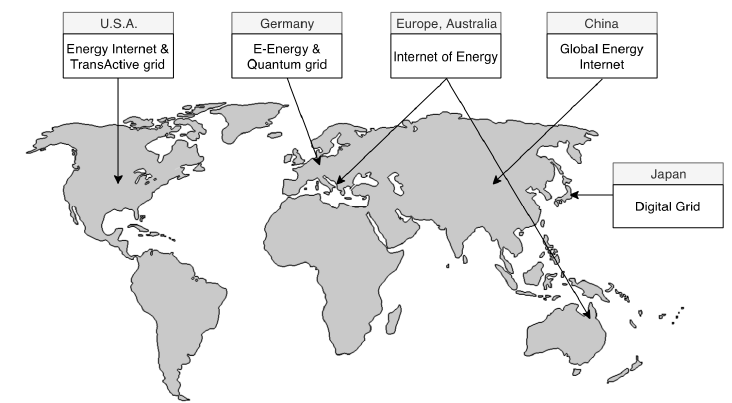
Figure 1. Energy Internet across the globe. Sources: [29–34].